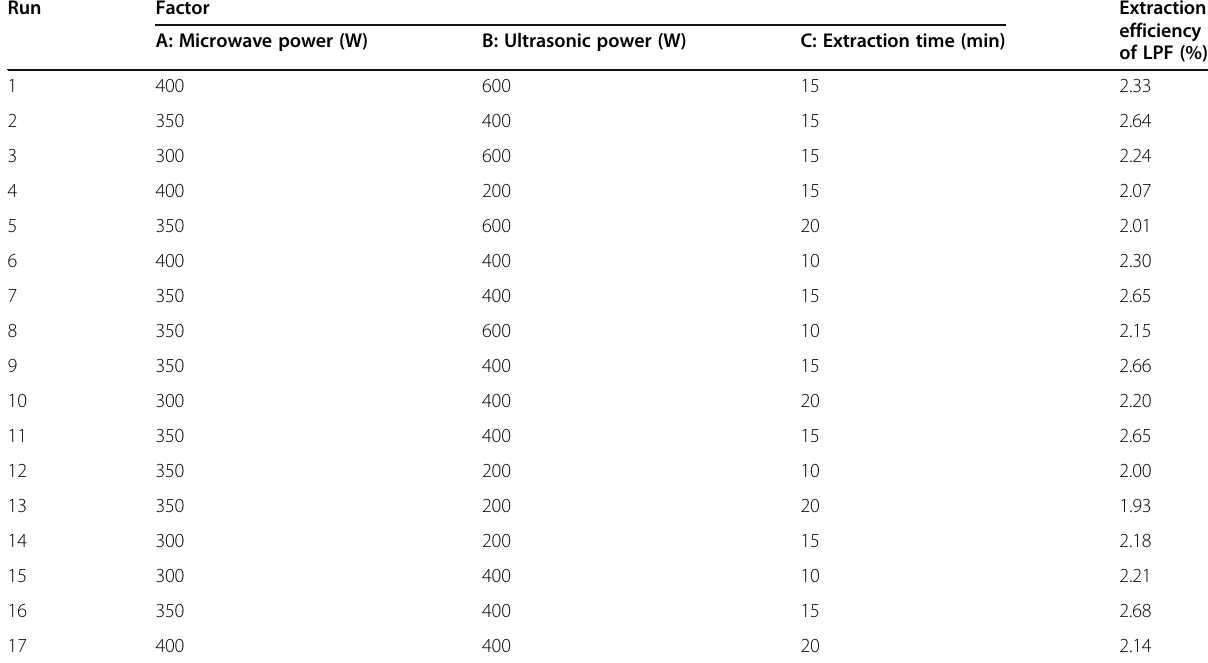
Table 1 Box-Behnken design and predicted values of flavonoids from L. plumule Run